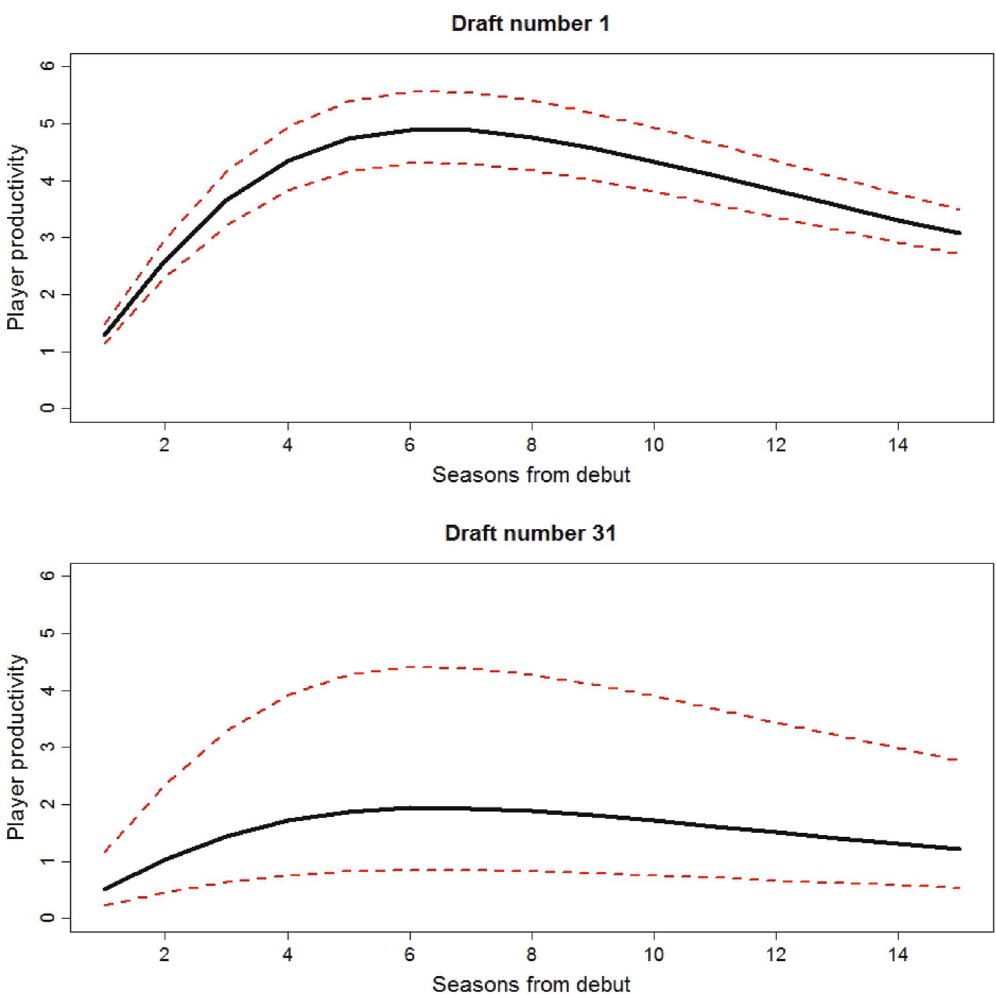
Figure 2. The player productivity as a function of seasons played (or age) for draft numbers 1 (top) and 31 (bottom) under the base- case parameter set. The median player productivity is shown in black, with 1 st and 99 th percentiles in red.